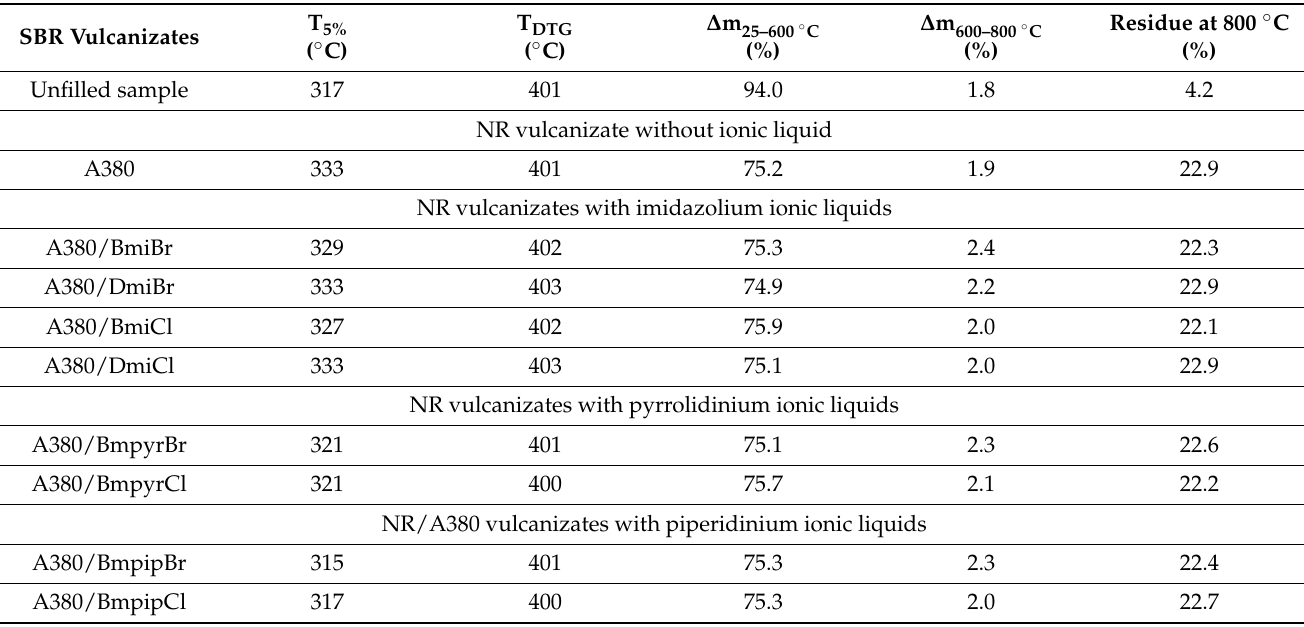
Table 9. Onset temperature of thermal decomposition (T 5% ), DTG peak temperature (T DTG ) and total mass loss ( ∆ m) during decomposition of the silica-filled NR composites containing ILs